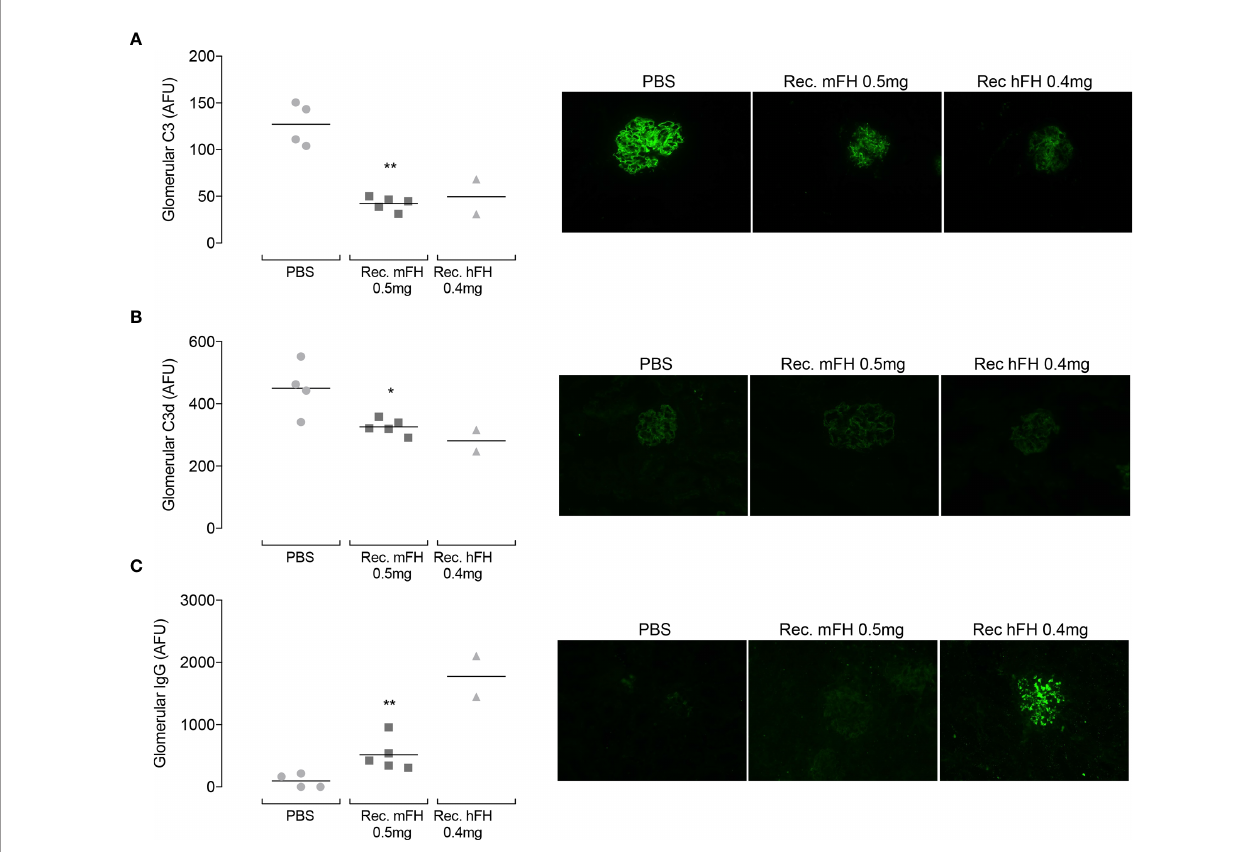
FIGURE 8 | Glomerular C3 immunostaining in CFH -/- mice following repeat dosing of FH. Animals received ten daily injections of recombinant mFH or recombinant hFH (or vehicle) and were culled at day 11. Glomerular C3 (A) , C3d (B) and IgG (C) were assessed, and representative images shown. Quantitation of fl uorescence intensity, in arbitrary fl uorescent units, is plotted with horizontal bars denoting mean values. *P=0.0317, **P=0.0159 versus PBS, Mann-Whitney